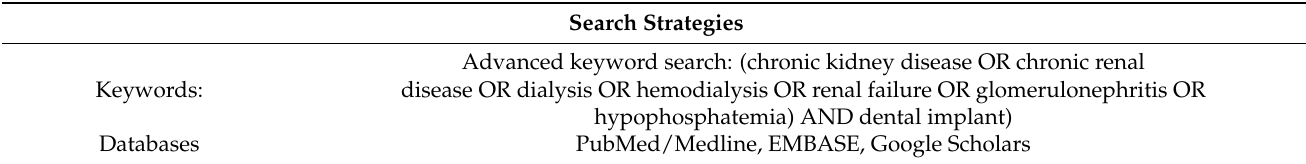
Table 2. Screening strategy by Boolean search. Search